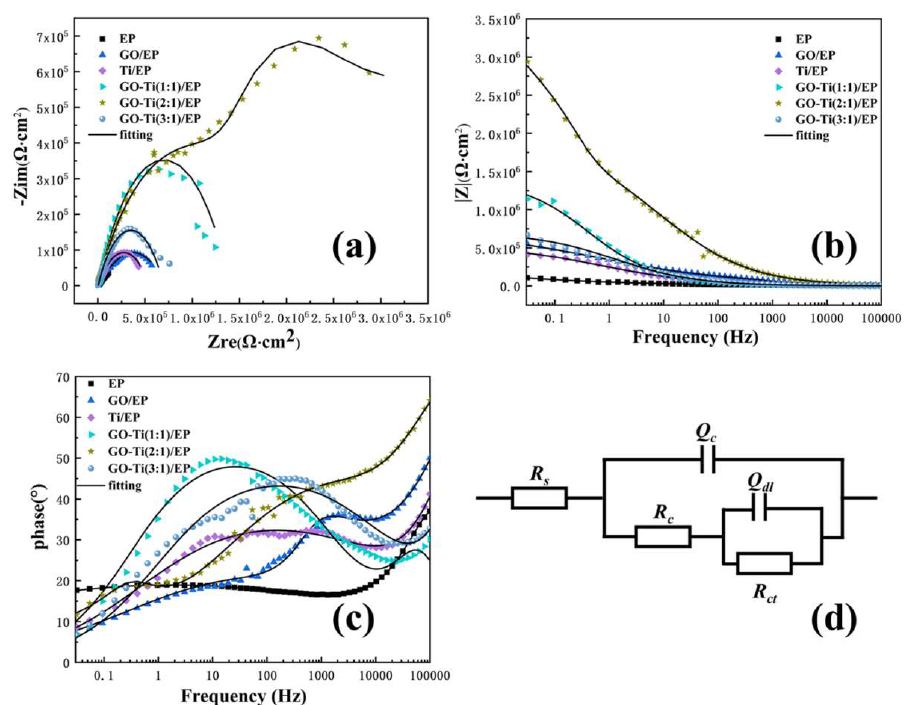
Table 1. The electrochemical parameters extracted from electrochemical impedance spectroscopy (EIS) data of the EP, GO/EP, Ti/EP, and GO from Table 1. GO-Ti(3:1)/EP and GO-Ti(2:1)/EP samples immersed in 3.5 wt % NaCl solution for different times.